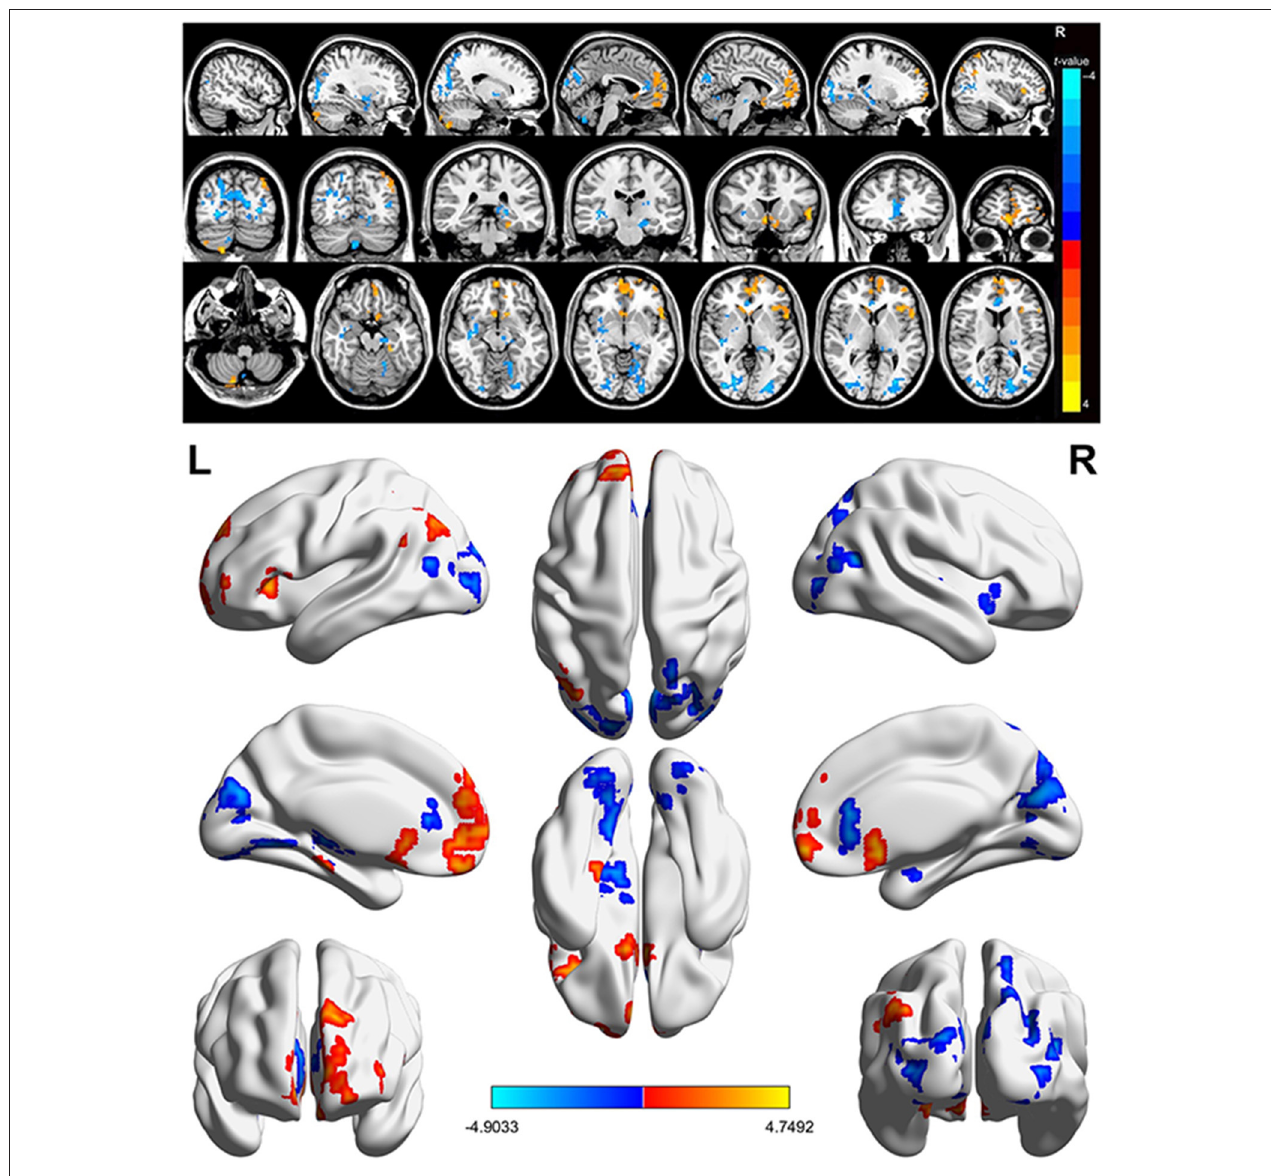
FIGURE 2 | Spontaneous brain activity in MGD patients in SO population. Red regions (left lingual gyrus, right lenticular globus pallidus, right anterior cingulate and paracingulate gyrus, left middle occipital gyrus) indicate higher fALFF values, while blue regions (right cerebellum, left fusiform gyrus, right medial orbitofrontal gyrus, left triangle inferior frontal gyrus, left inferior parietal gyrus) represent lower fALFF values ( P < 0.05; AlphaSim-corrected; cluster size, > 40). SO, severe obesity; MGD, meibomian gland dysfunction; fALFF, fractional amplitude of low-frequency